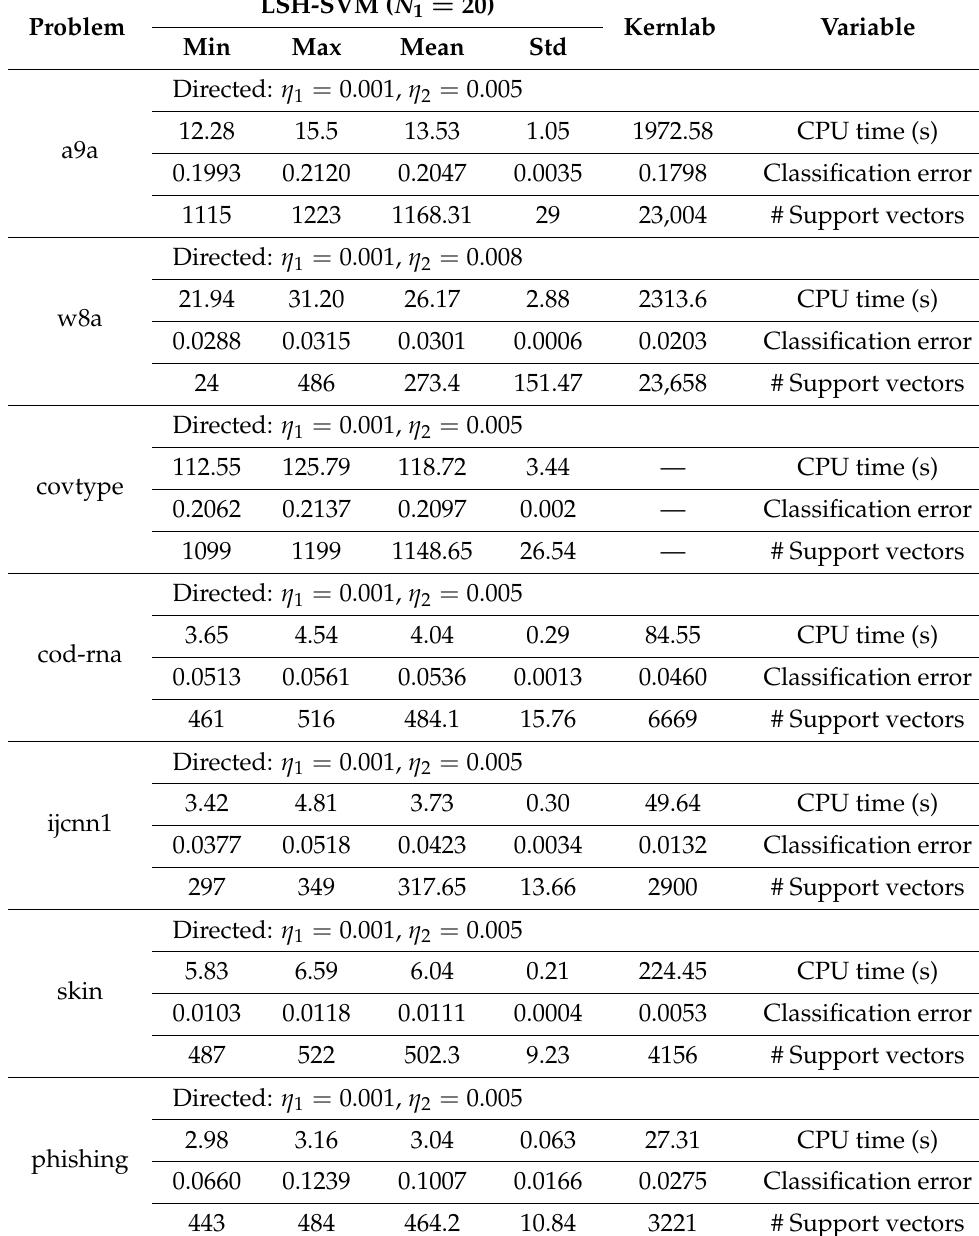
Table 2. LSH-SVM Algorithm 2 vs.